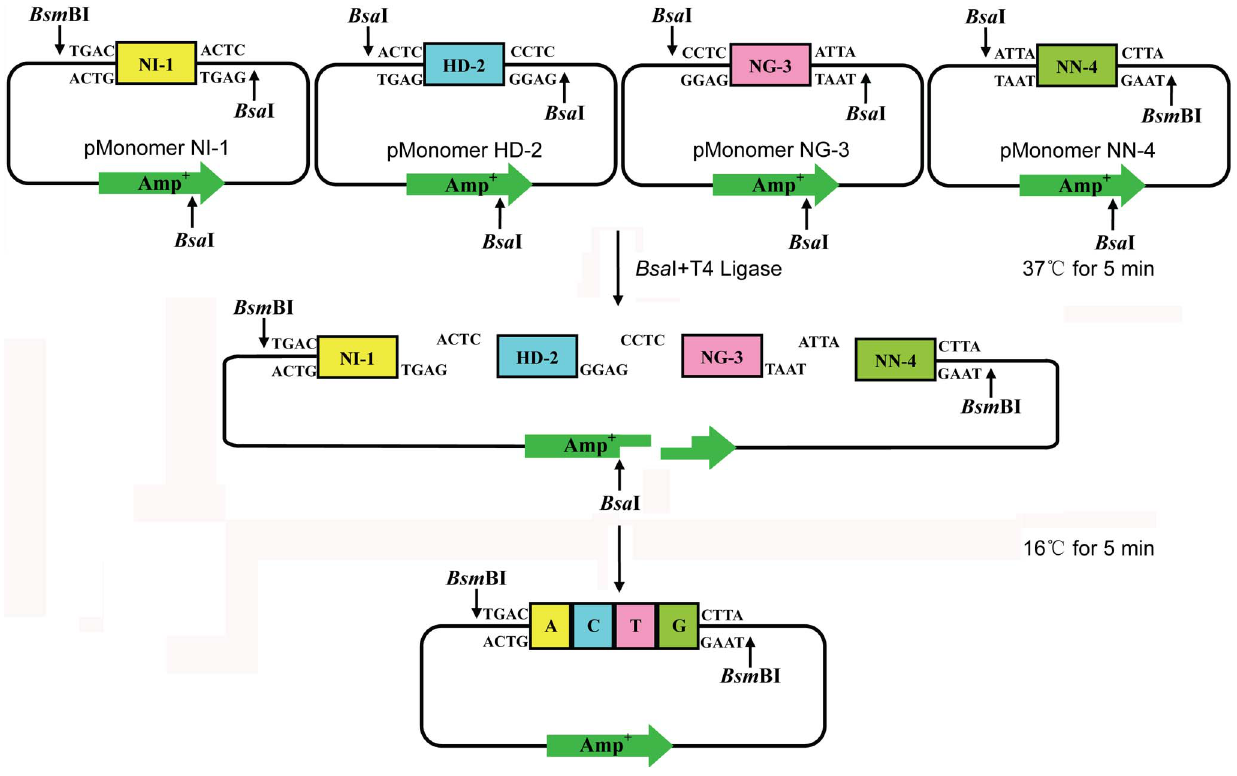
Figure 3. Schematic representation of the cut/ligation reaction for tetramer plasmid construction. 4 selected monomer plasmids at each position (NI-1, HD-2, NG-3 and NN-4 for example in this Figure) are put into a reaction pool containing T4 DNA ligase, Bsa I and ligase buffer. Once the temperature rises to 37 u C, the right side of NI-1, both sides of HD-2, NG-3 and the left side of NN-4 are digested by Bsa I. The unique cohesive ends facilitate the positioning of each monomer in the ligation product. T4 DNA ligase joins the fragments together at 16 u C. The number of constructed tetramer plasmids increases as the cycles continue.